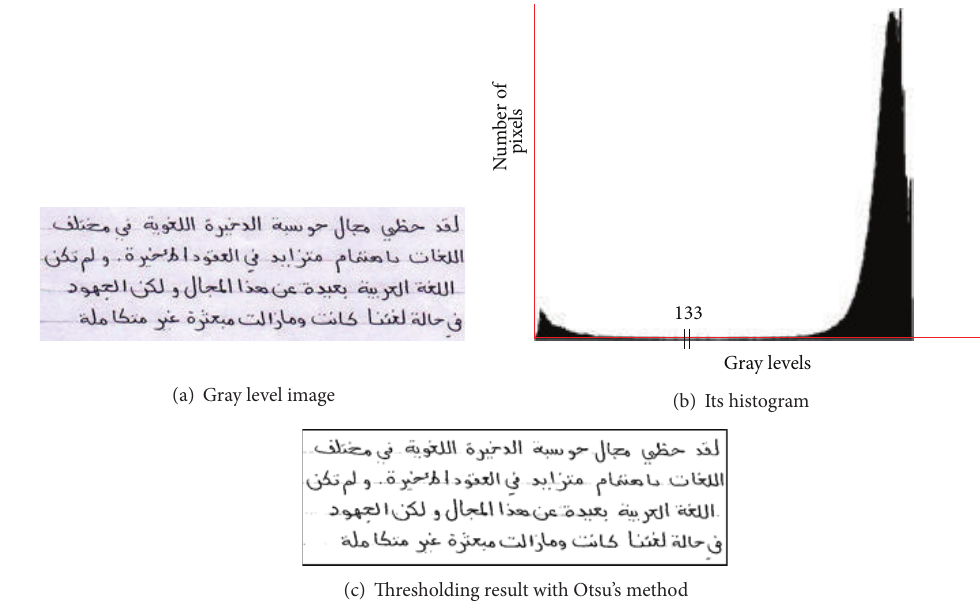
Figure 1: Global thresholding of a bimodal